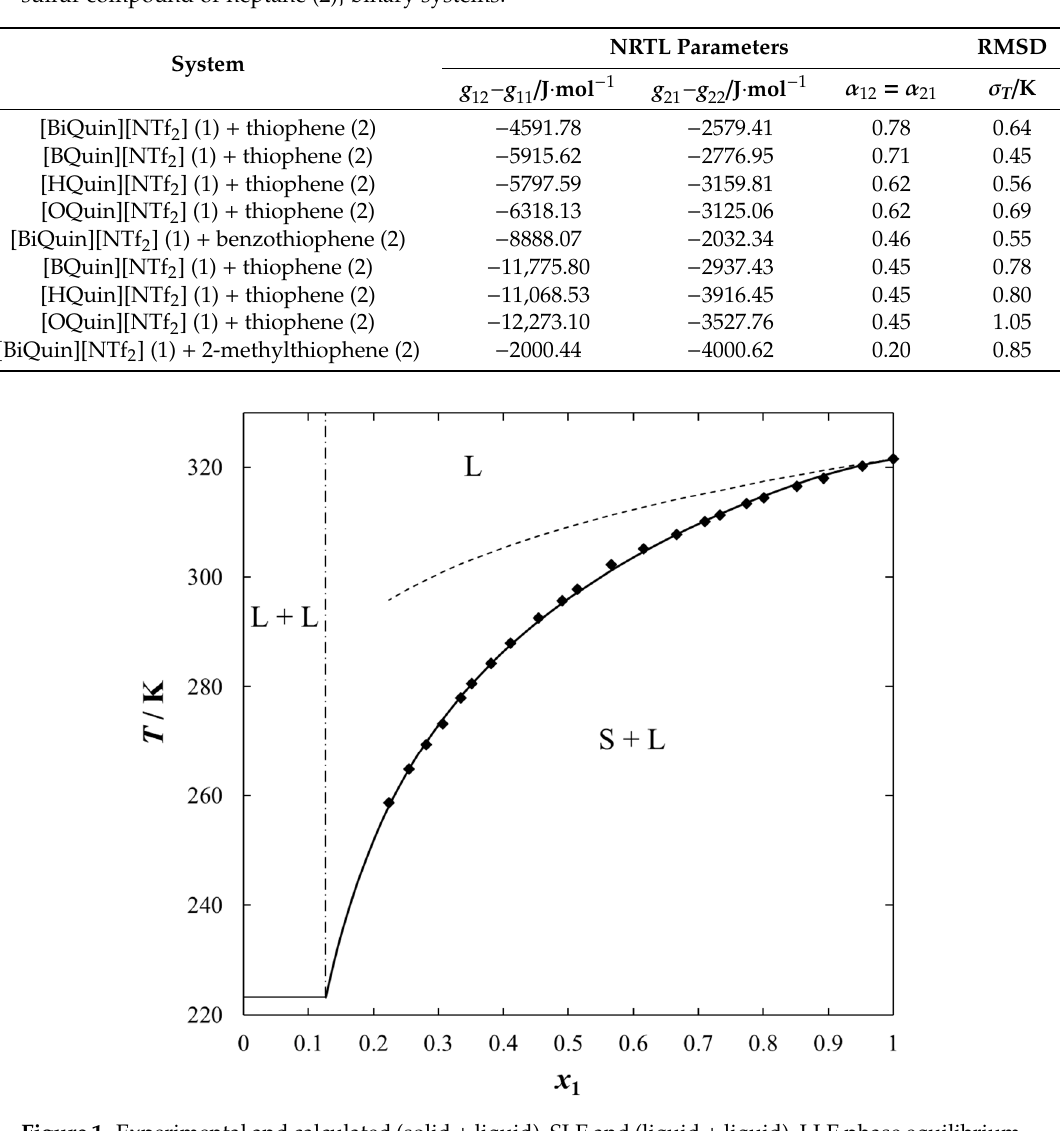
Table 5. The NRTL fitting parameters, obtained by the correlation of the SLE data for {IL (1) + organic sulfur compound or heptane (2)} binary systems.